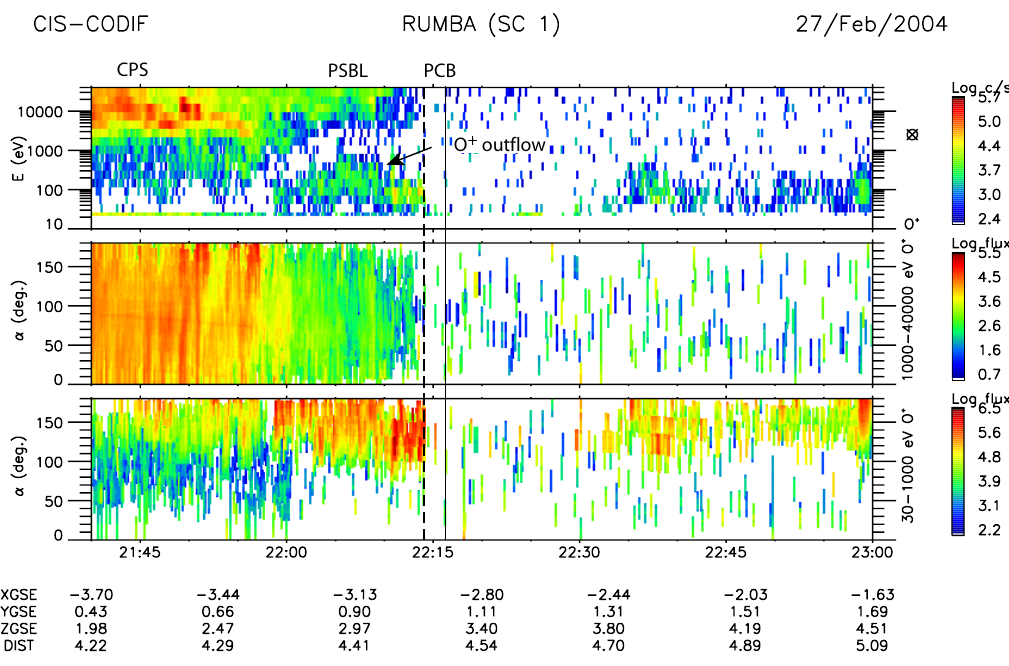
Fig. 7. Omnidirectional CIS CODIF spectrograms for O + ions in corrected-for-detection-efficiency counts per sec (top), pitch angle distri- bution for the upper energy population (1–40keV), in particle flux units (ions cm − 2 s − 1 sr − 1 keV − 1 ) (middle) and pitch angle distribution for the lower energy population (30eV–1keV)